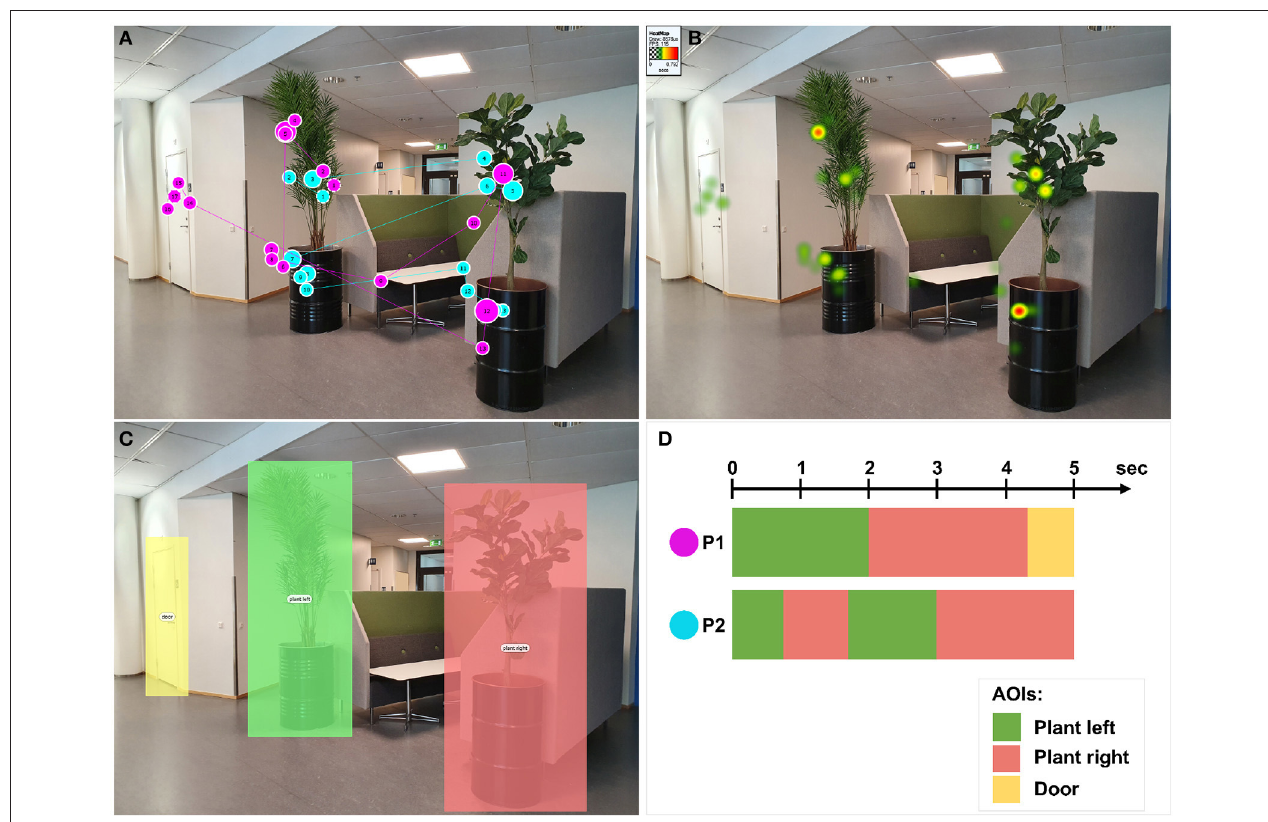
FIGURE 1 | Examples of 2D gaze data visualization techniques. (A) Top-left: scanpaths of two participants (P1 in magenta and P2 in cyan) visualized with Tobii Studio software. (B) Top-right: heat map of the two participants showing the aggregated fixations duration, visualized with Tobii Studio software. (C) Bottom-left: definition of three areas of interest (AOIs). (D) Bottom-right: Schematic representation of a scarfplot visualization for the three pre-defined